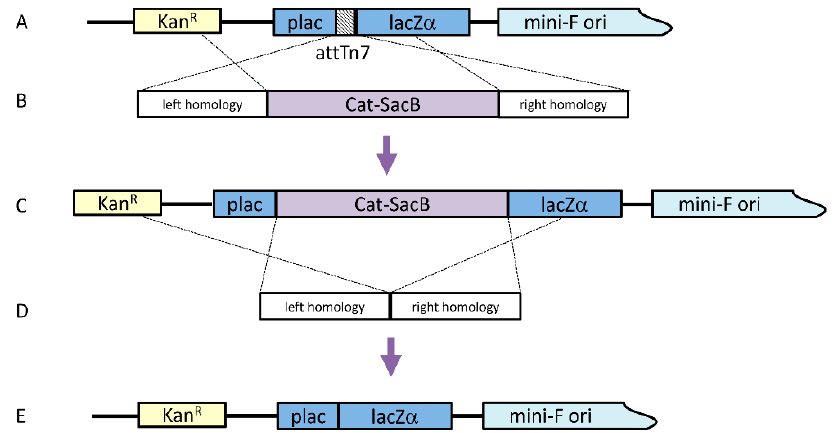
Figure 2. Construction of Δ attTn7 bacmid. ( A ) Parent strain; ( B ) linear attTn7 removal cassette; ( C ) ( C ) intermediate Cat-SacB strain; ( D ) linear removal marker; ( E ) final strain. intermediate Cat-SacB strain; ( D ) linear removal marker; ( E ) final strain.